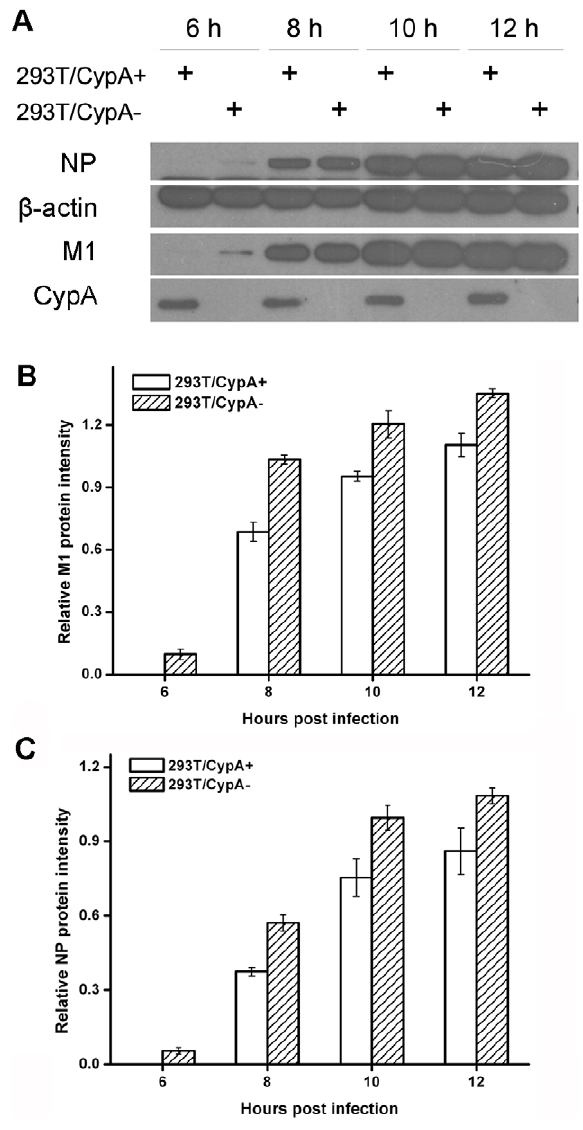
Figure 5. CypA inhibited the replication of influenza virus at the viral protein level. The 293T/CypA + and 293T/CypA 2 cell lines were infected with influenza A virus (MOI=0.1) and lysed in lysis buffer at 6, 8, 10, and 12 h post-infection The samples were analyzed by western blotting with a polyclonal anti-CypA antibody, monoclonal anti-M1 antibody, and polyclonal anti-NP antibody; b -actin was used as a control (A). Relative expression levels of M1 (B) and NP (C) were calculated by quantifying the results shown in panel (A). Data are means 6 SD of three separate experiments.